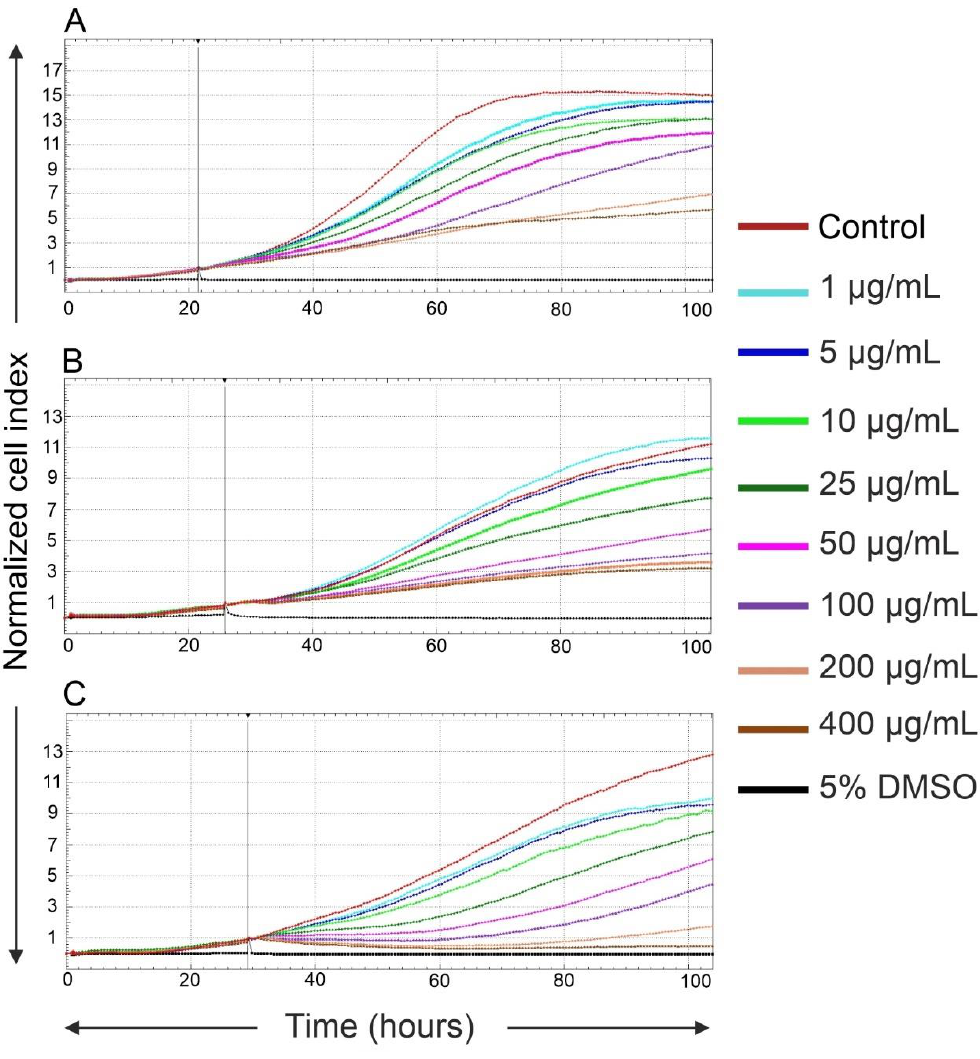
Figure 5. Growth kinetics of human A549 ( A ), HepG2 ( B ), and MCF-7 ( C ) cells treated with Fe 3 O 4 @SiO 2 -SH nanoparticles at 1, 5, 10, 25, 50, 100, 200, and 400 µg/mL — dynamic real-time monitoring of proliferation and cytotoxicity by the xCELLigence system dedicated to adherent cell lines. The black vertical line indicates the time point when the tested nanoparticles were added. Cells treated with 5% H 2 O were used as vehicle control, whereas cells treated with 5% dimethyl sulfoxide (DMSO) were used as a positive control. The normalized cell index was measured over 72 h. Plots shown are representative of at least three replicate experiments in each case.